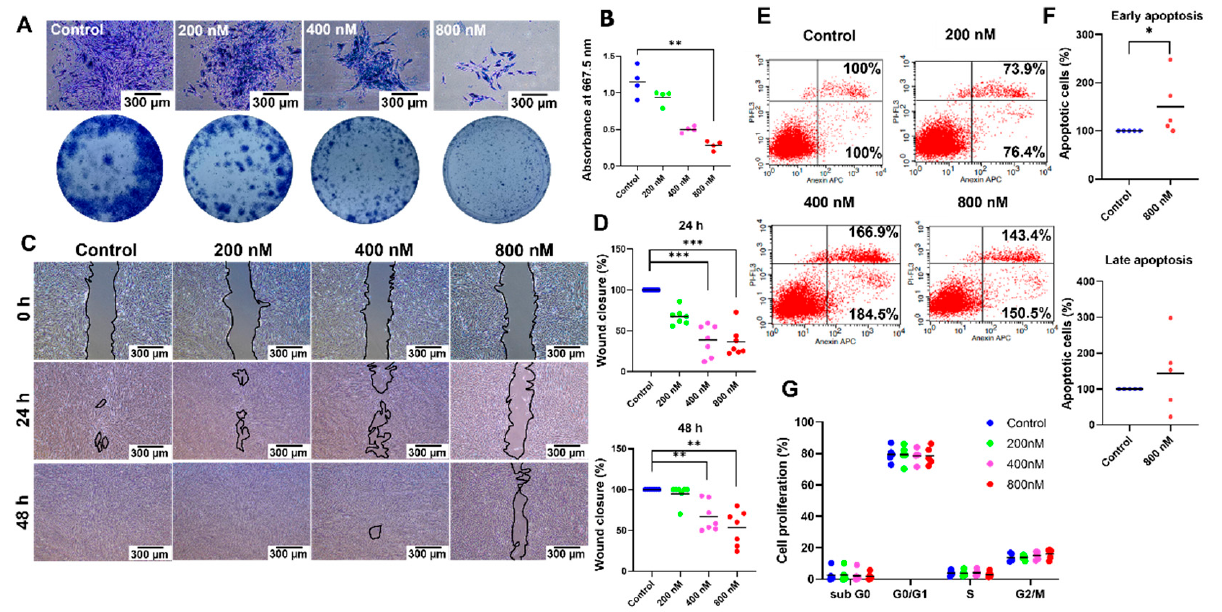
Figure 2. 6-bromoindirubin-3 ′ -oxime (BIO) attenuates hDPSC colony-forming unit ability and cell migration by inducing early apoptosis. ( A ) Colony-forming unit assay. Scale bars: 300 µm. ( B ) The staining was solubilised, and the absorbance was determined. ( C ) Representative images of the in vitro scratch assay at 0, 24, and 48 h. Scale bars: 300 µm. ( D ) Quantification results of the percentage migration. ( E , F ) Flow cytometry analysis of the apoptotic cells. The left upper and lower panels show dead cells and live cells, respectively. Right upper and lower panels indicate late apoptotic cells and early apoptotic cells, respectively. ( G ) Cell cycle analysis was performed using flow cytometry. Bars indicate a significant difference between groups (* p < 0.05. ** p < 0.01. *** p < 0.001).